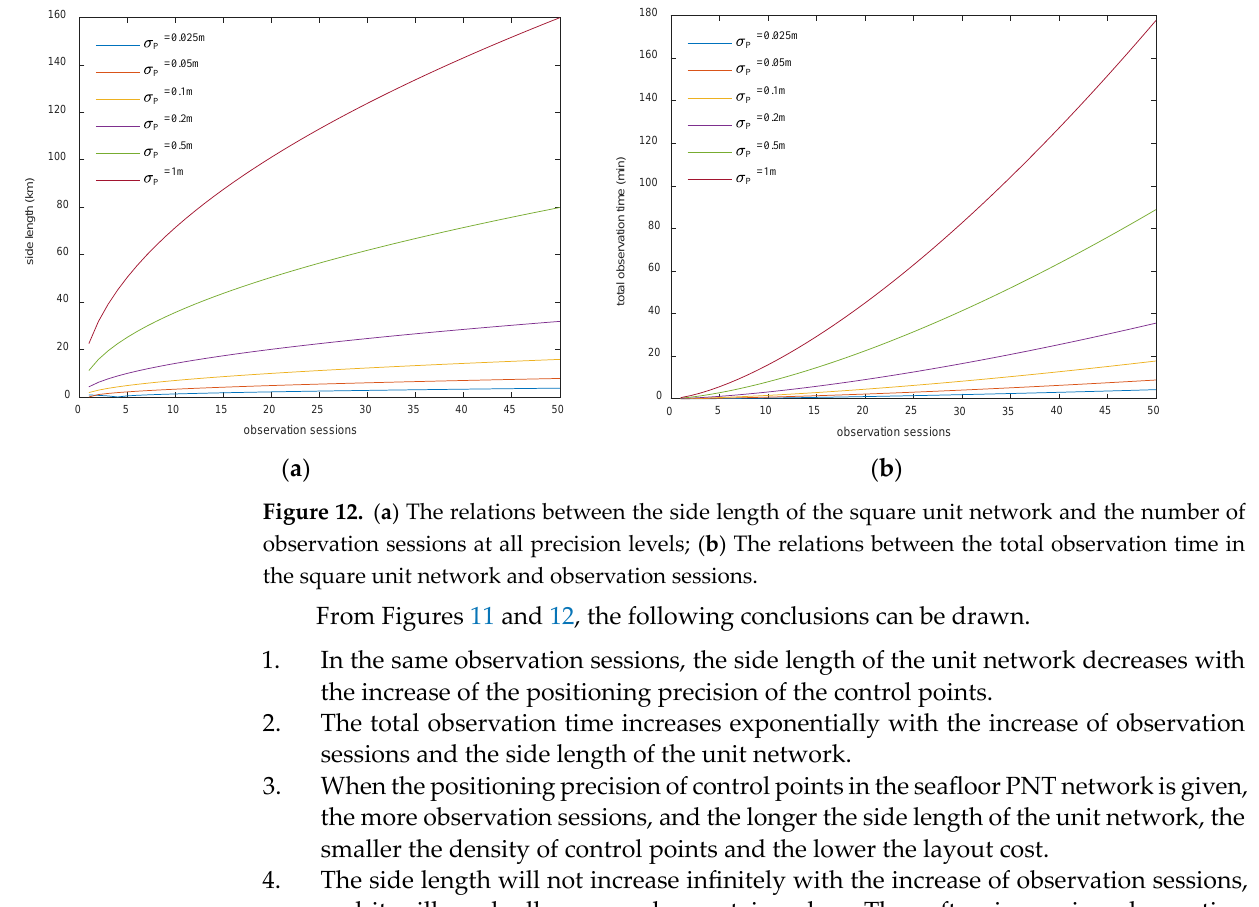
Figure 11. ( a ) The relations between the side length of the equilateral triangle unit network and the number of observation sessions at all precision levels; ( b ) The relations between the total observa- tion time in the equilateral triangle unit network and observation sessions.